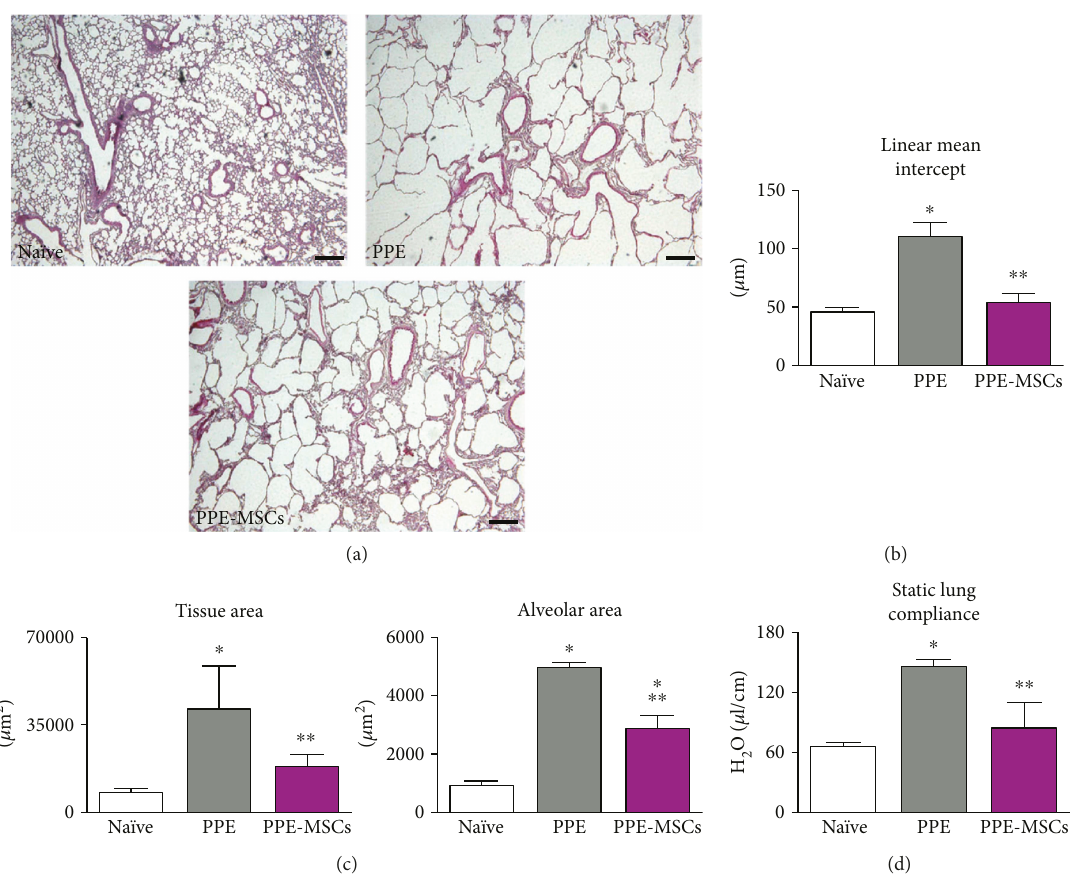
Figure 2: Lung histology and function. (a) Hematoxylin/eosin staining on lung tissue at day 31. (b) Morphometric analysis of the mean linear intercept. (c) Quanti fi cation of tissue and alveolar area per alveolus. (d) Functional measurements of static lung compliance. Data are expressed as the mean ± SD ( n = 6 in each experimental group). Scale bars: 200 μ m. ∗ P < 0 05 versus naïve; ∗∗ P < 0 05 versus